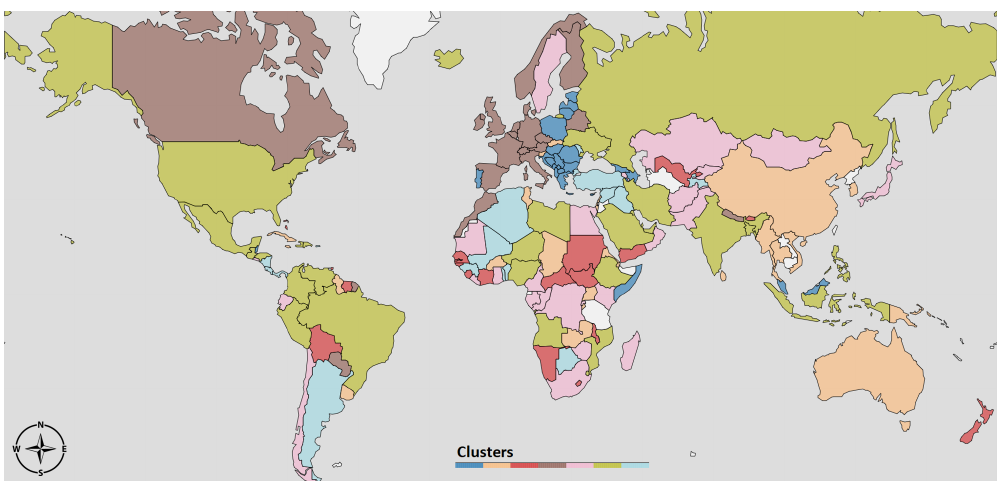
( t ) curves. R curve goes and R